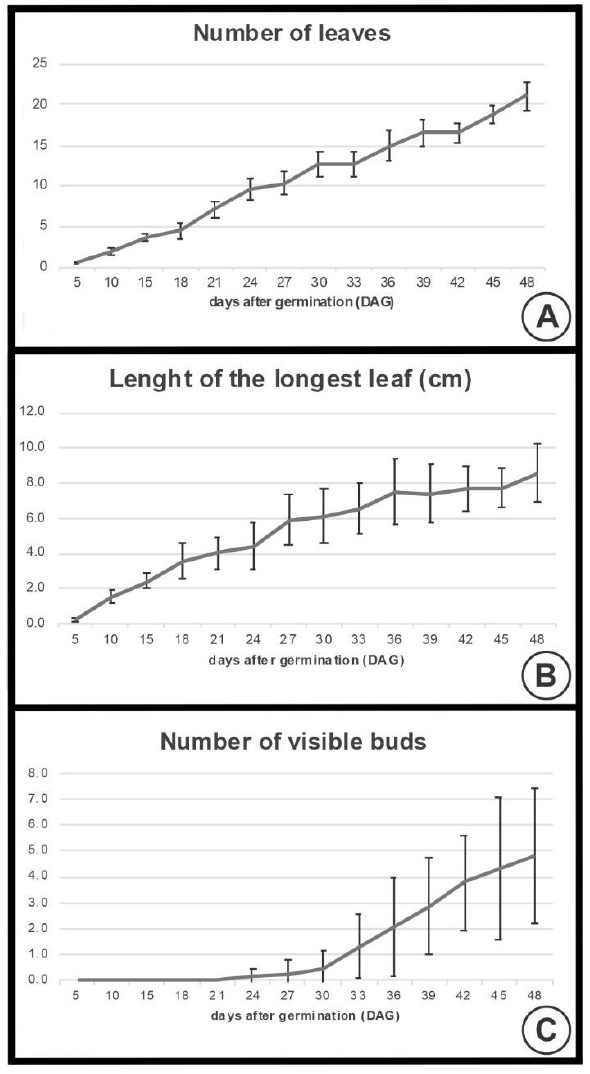
Figure 5. Development of Taraxacum kok-saghyz 5 to 48 days after germination (DAG). ( A ) Number of leaves. ( B ) Length of the longest leaf (cm). ( C ) Number of visible inflorescence buds. n = 13–31. Bars represent the standard deviation (SD).